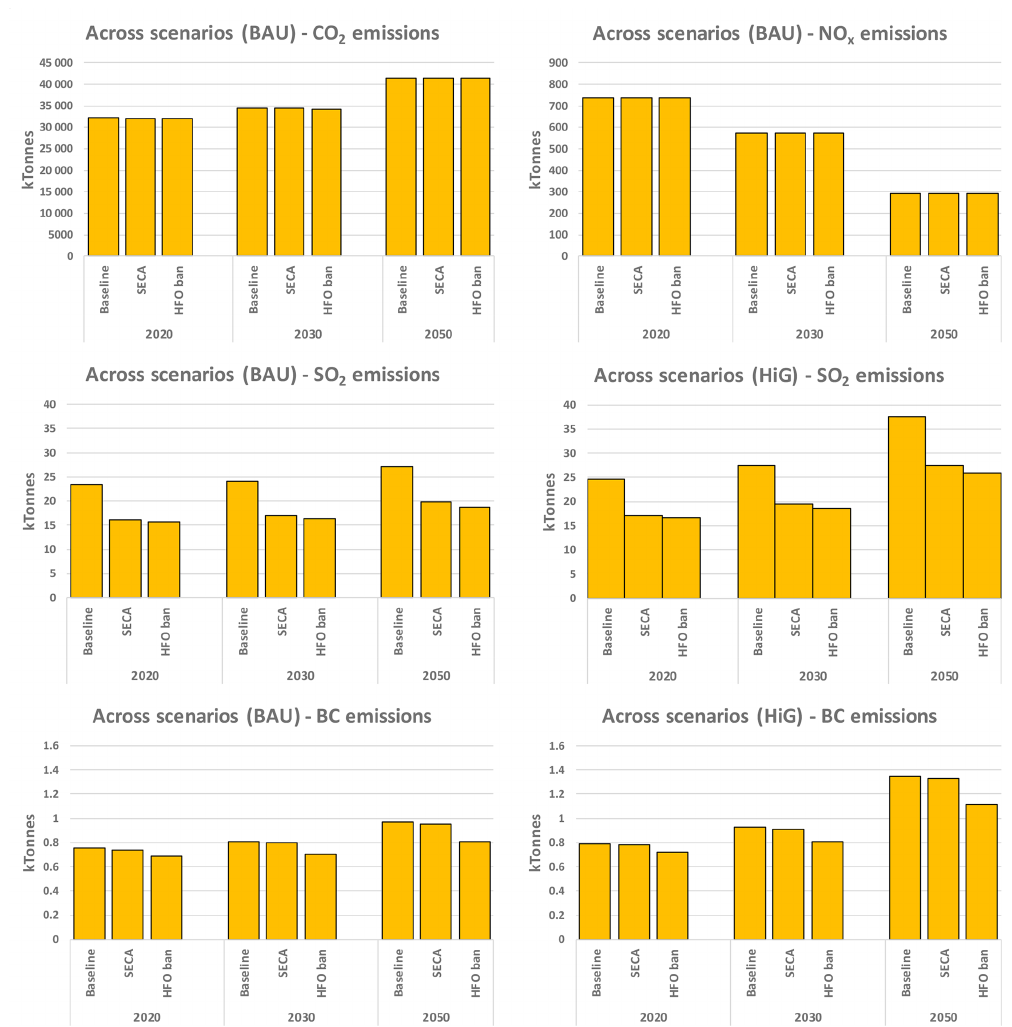
Figure 3. Emissions for domain d03 calculated in the Baseline, SECA and HFO ban BAU scenarios (CO 2 , NO x , SO 2 and BC) and the HiG scenarios (SO 2 and